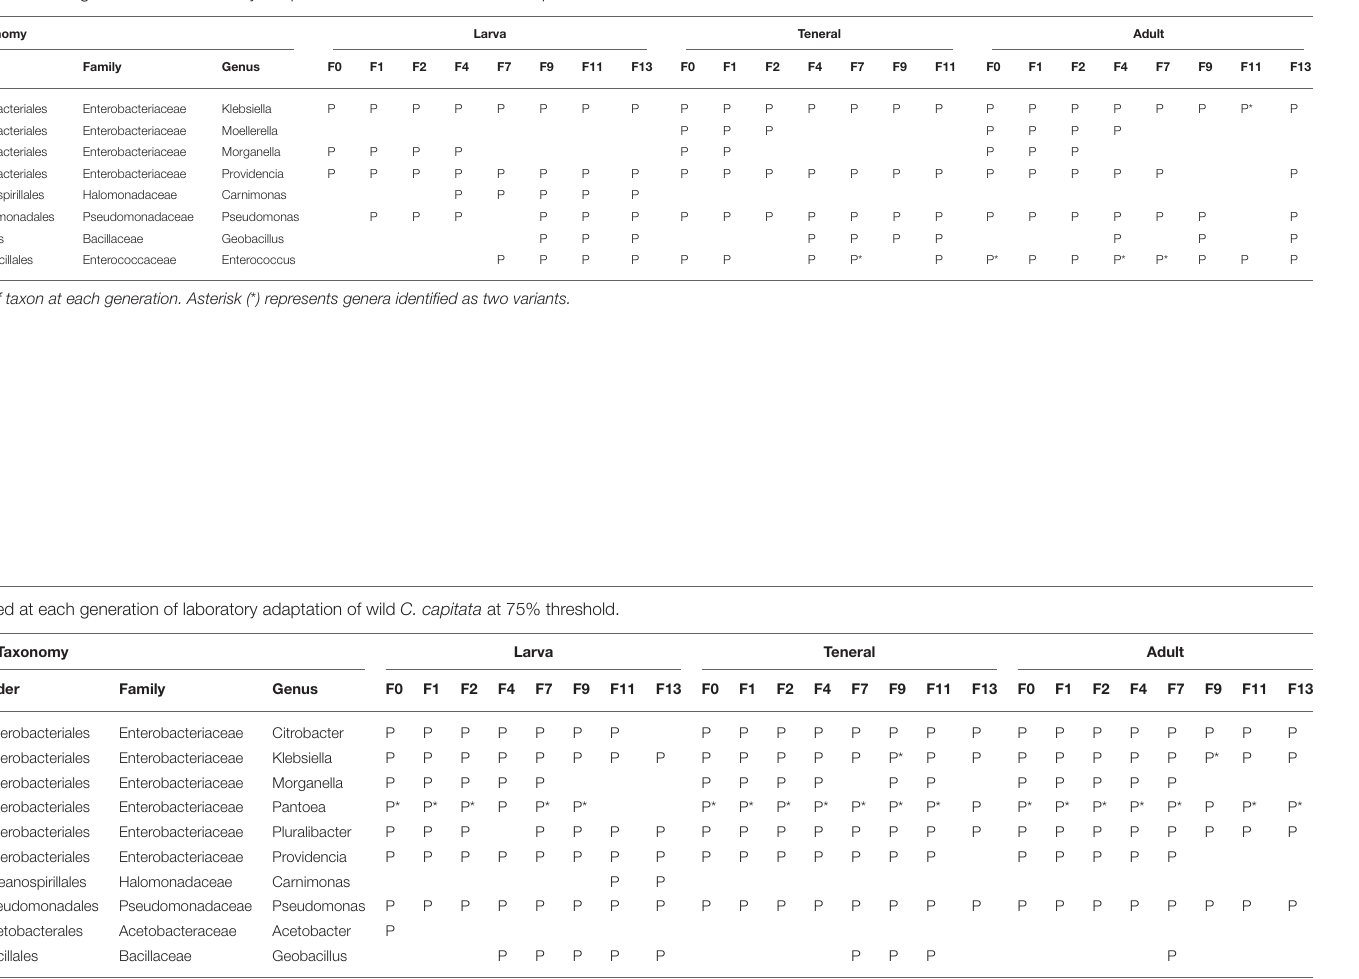
TABLE 1 | Core bacterial taxa determined at each generation of laboratory adaptation of Vienna 8 FD-GSS C. capitata at 75% threshold.